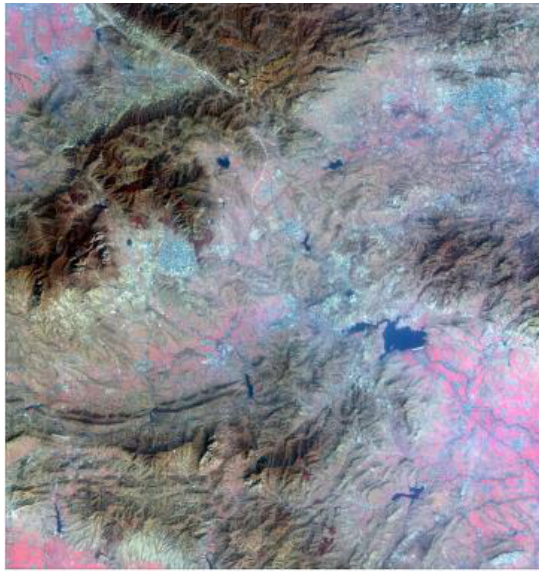
Figure 4. Multispectral image of ZY-3 satellite.